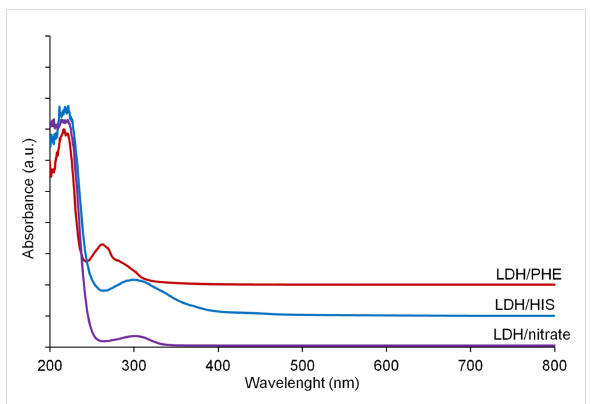
Figure 5: Diffuse reflectance UV–vis spectra (Kubelka–Munk func- tions) of Mg 2 Al LDHs.